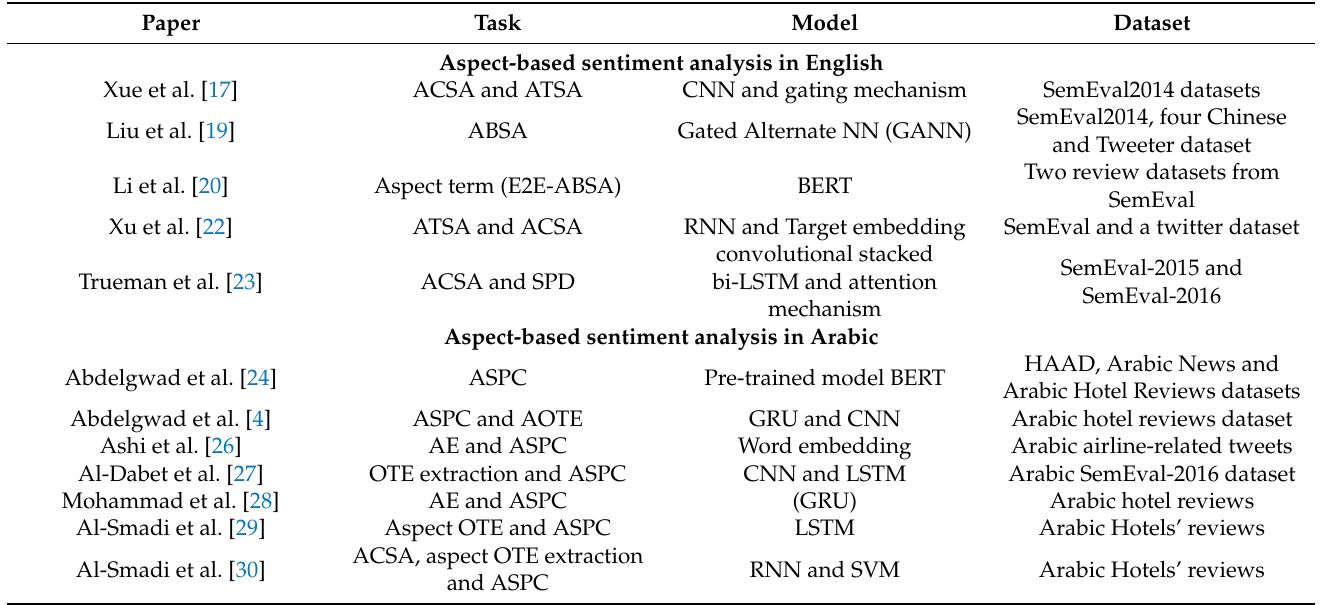
Table 1. Summary of the related works.